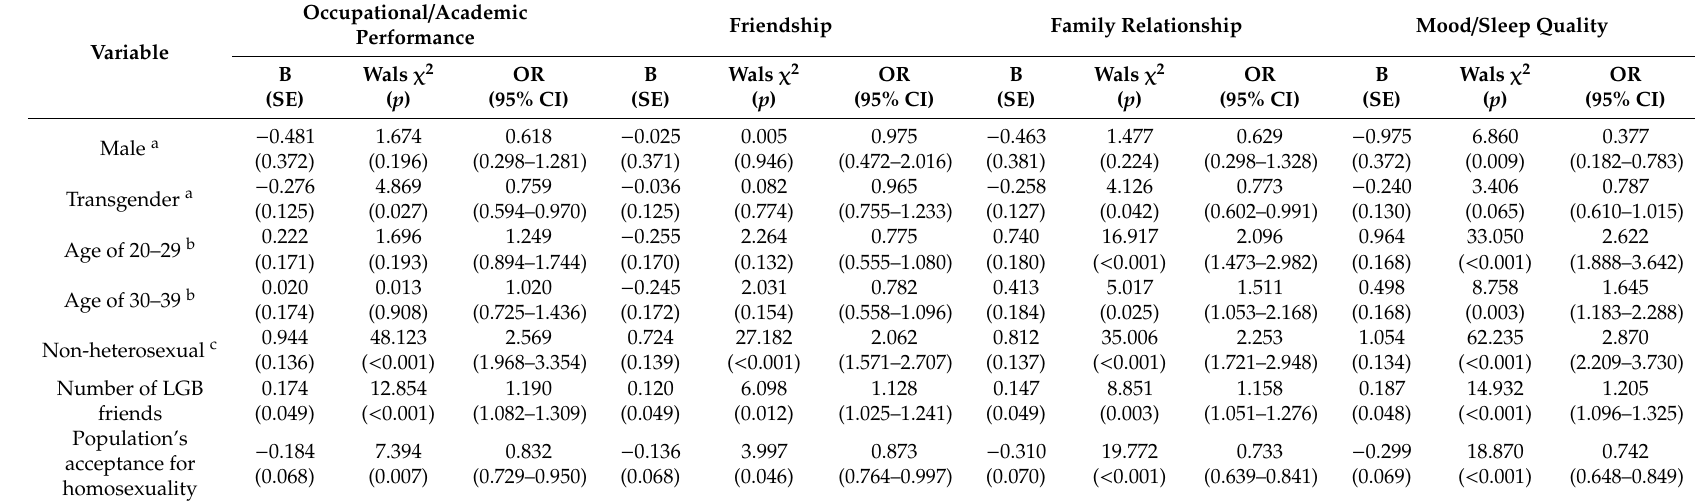
Table 2. Factors related to the negative impacts of debates on legalizing the same-sex relationship on daily